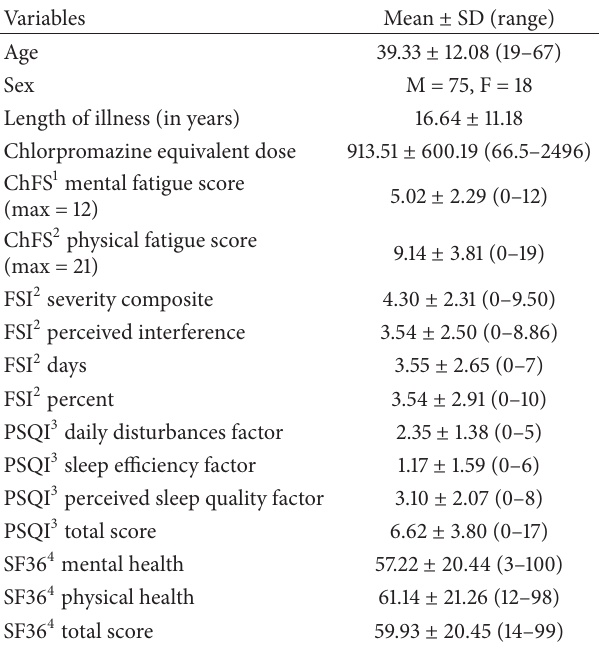
Table 1: Demographic and clinical characteristics for all participant, and scores on the PSQI, ChFS FSI, and SF36